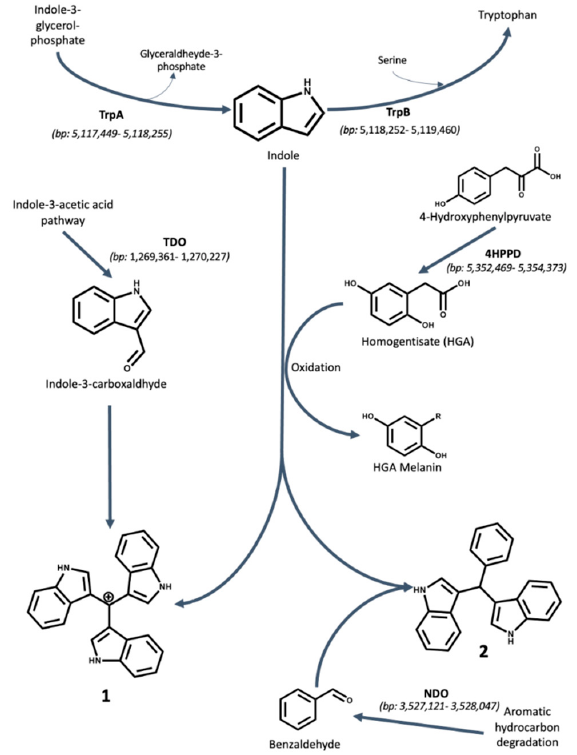
Figure 2. Proposed biosynthesis mechanisms for Compounds 1 and 2 by P. aeruginosa UWI-1. Indole is proposed to originate from tryptophan degradation via an unclassified carbon–carbon lyase. The oxidative polymerization of homogentisate (HGA) to HGA melanin serves as the catalyst for the formation of compounds 1 and 2 . Compound 1 is putatively formed via condensation of two molecules of indole and one molecule of indole-3-carboxaldehyde. Indole-3-carboxaldehyde is an intermediate product in the IAA synthesis pathway found in Pseudomonads. Compound 2 is putatively formed by the condensation of two molecules of indole and one molecule of benzaldehyde. Benzaldehyde is proposed to be derived as a product of polycyclic aromatic hydrocarbon metabolism by naphthalene 1,2-dioxygenase. The location of each gene involved in the biosynthesis is given in parentheses and is based on the genome of P. aeruginosa UWI-1 available from the European Nucleotide Archive (ENA) project number PRJEB32405 (https: // www.ebi.ac.uk / ena / data / view /